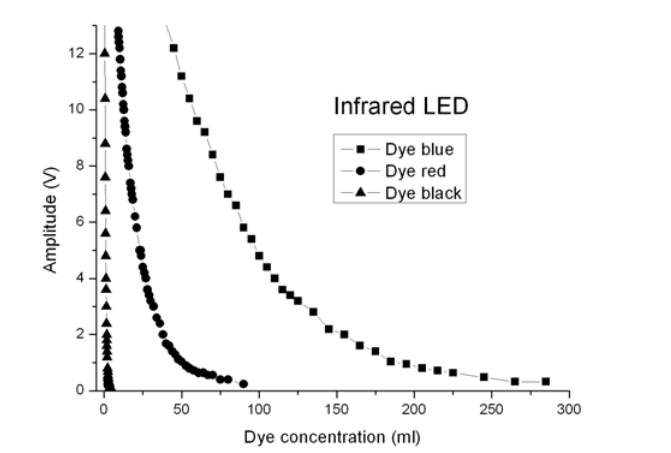
Figure 9. Tests with a infrared LED where λ = 880